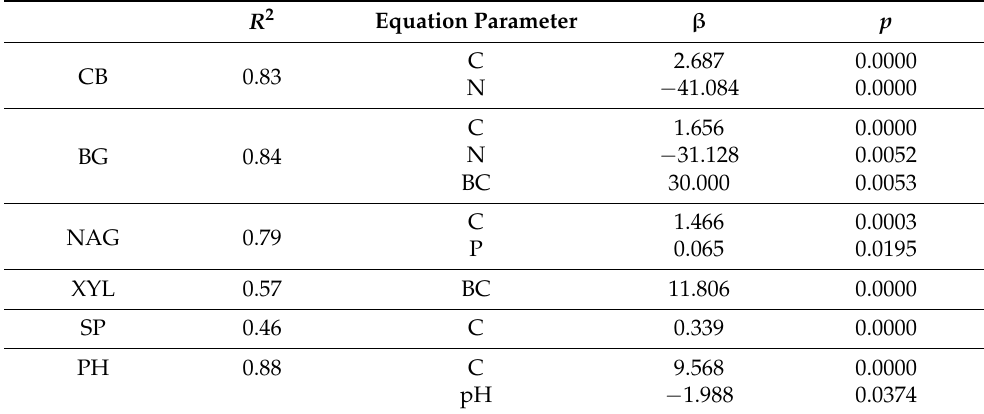
Table 5. Multiple regression analysis for enzyme activity based on properties of soil from charcoal hearth horizon (RCH) (experiment 2). R 2 Equation Parameter β